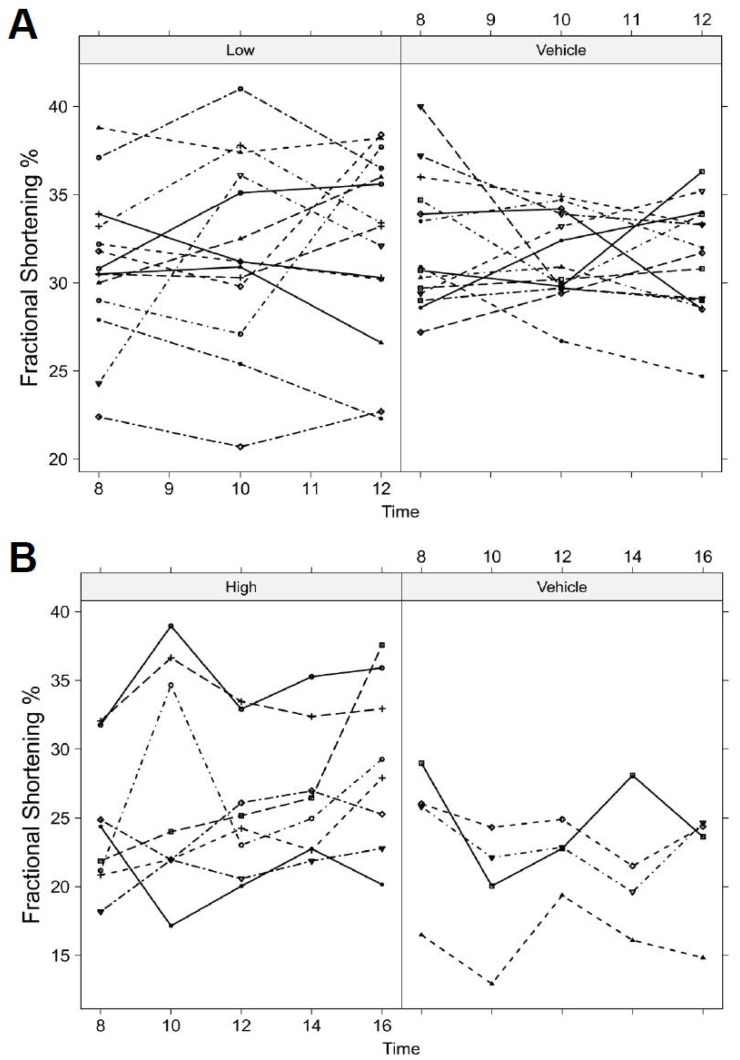
Effect of GGF2 treatment on cardiac function late after MI.A) Low dose GGF2: Rat FS % values were progressively reduced in both vehicle (n = 14) and low dose GGF-2 treated (n = 14) animals with time. The estimated mean FS% and range at 12 weeks post-MI was 32.9 (30.5, 35.3) for the low dose treated group and 31.7 (29.4, 33.9) for the vehicle group. Overall, the low dose treatment regimen did not restore late-post infarct LV structure and function because the average treatment effect was statistically insignificant (p = 0.51). B) High dose GGF2: FS % values decreased in vehicle (n = 4) animals and rose in high dose GGF2 treated (n = 8) rats with time. FS % was significantly increased in the high dose treated animals at 10,12,14, and 16 weeks post-MI (p = 0.013, p = 0.002, p = 0.002, and p = 0.017 respectively.) The estimated mean FS% and range at 16 weeks post-MI was 27.8 (24.1, 32.0) for the high dose treated group and 21.7 (18.1, 26.0) for the vehicle group. The average treatment effect of high dose GGF2 was found to be statistically significant (p = 0.005).